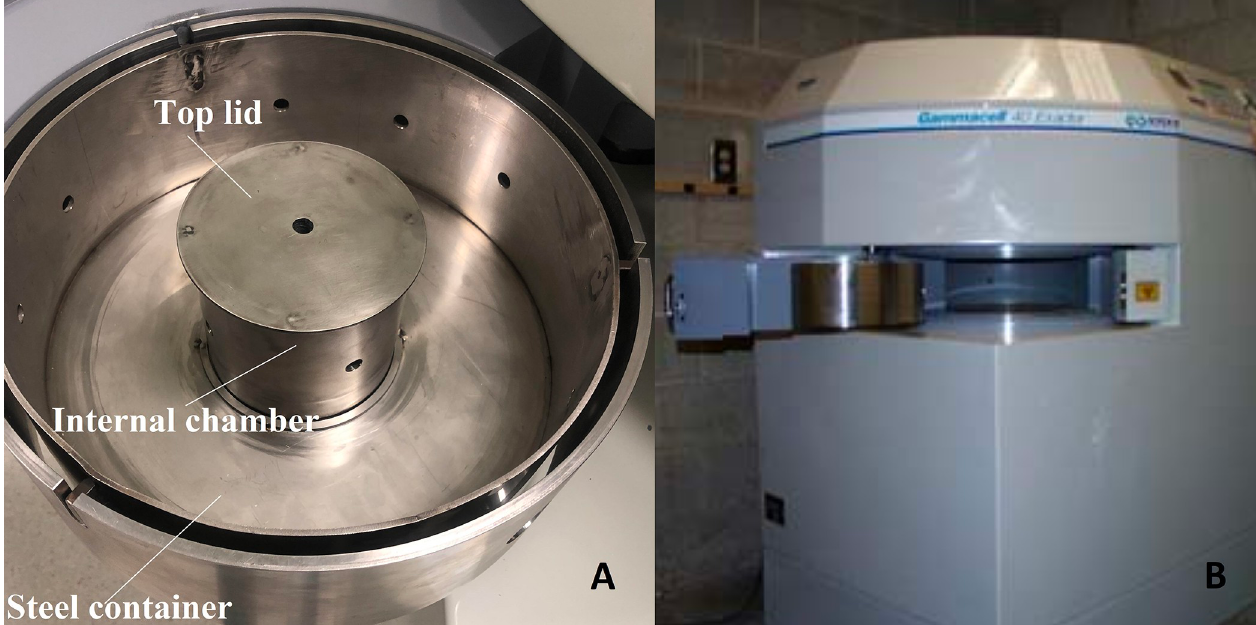
Fig 1. Add-on collimator and Gammacell irradiator. A) Add-on collimator components including the top lid, 1cm aperture, internal chamber, and the steel container to hold the collimator inside the irradiator. B) Collimator placed in the Gammacell 40 Exactor, prepared for